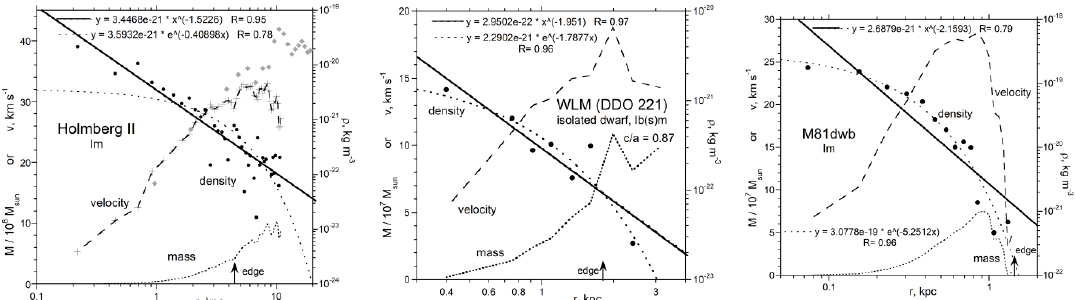
Figure A6. Spirals in Messier’s Cat alog studied by Sofue et al. [53,66]. These large and luminous galaxies have a variety of RC patterns. Tabular data were downloaded from [65].